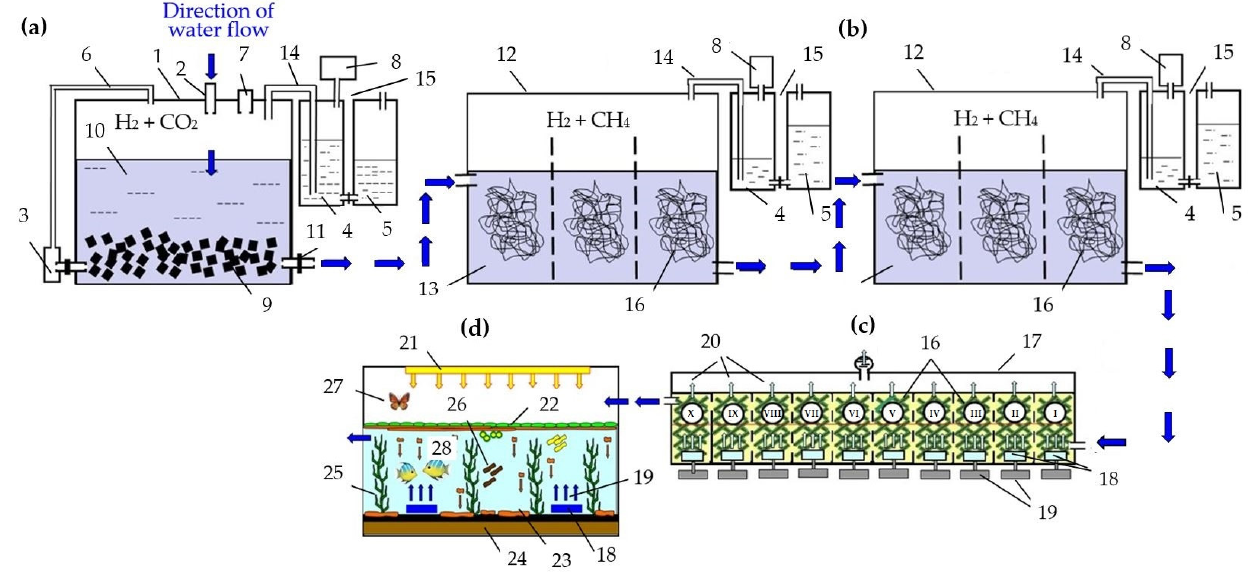
Figure 1. Scheme of the multifunctional direct flow installation for degradation of solid and liquid organic waste: ( a ) hydrogen bioreactor (240 L); ( b ) methane tank (two connected modules, 50 L each); ( c ) air tank (50 L); ( d ) aquarium (50 L): 1—steel body; 2—water supply fitting; 3—pump; 4—